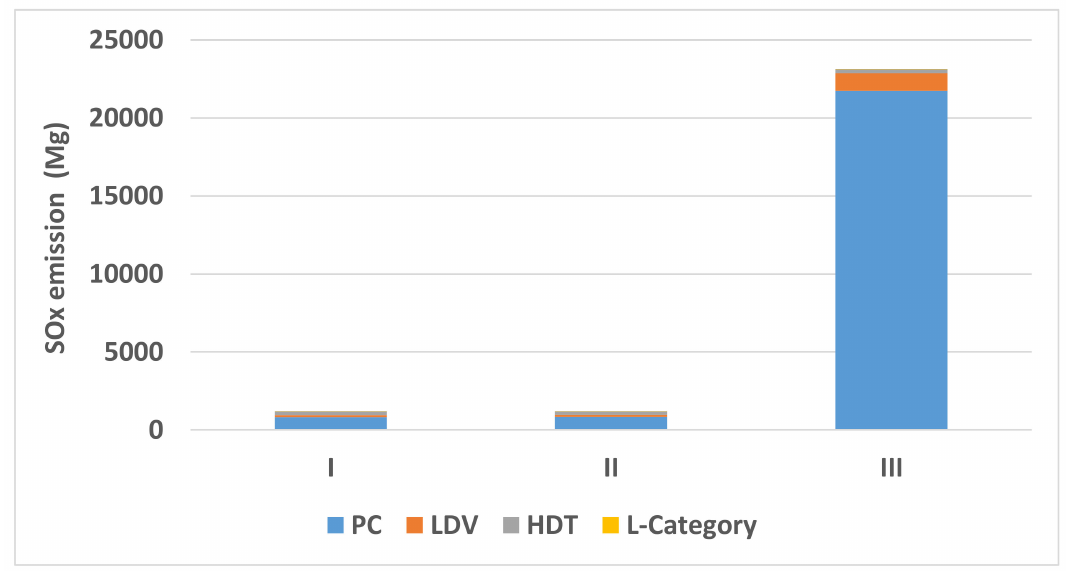
Figure 4. Comparison of SO x emissions for three